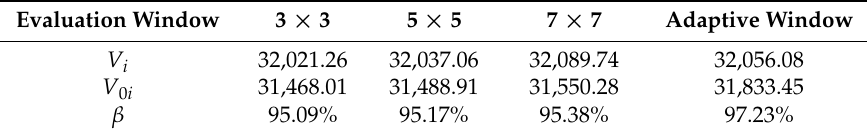
Table 5. Volume evaluation results of metal cones reconstructed by F SML at different evaluation windows/mm 3